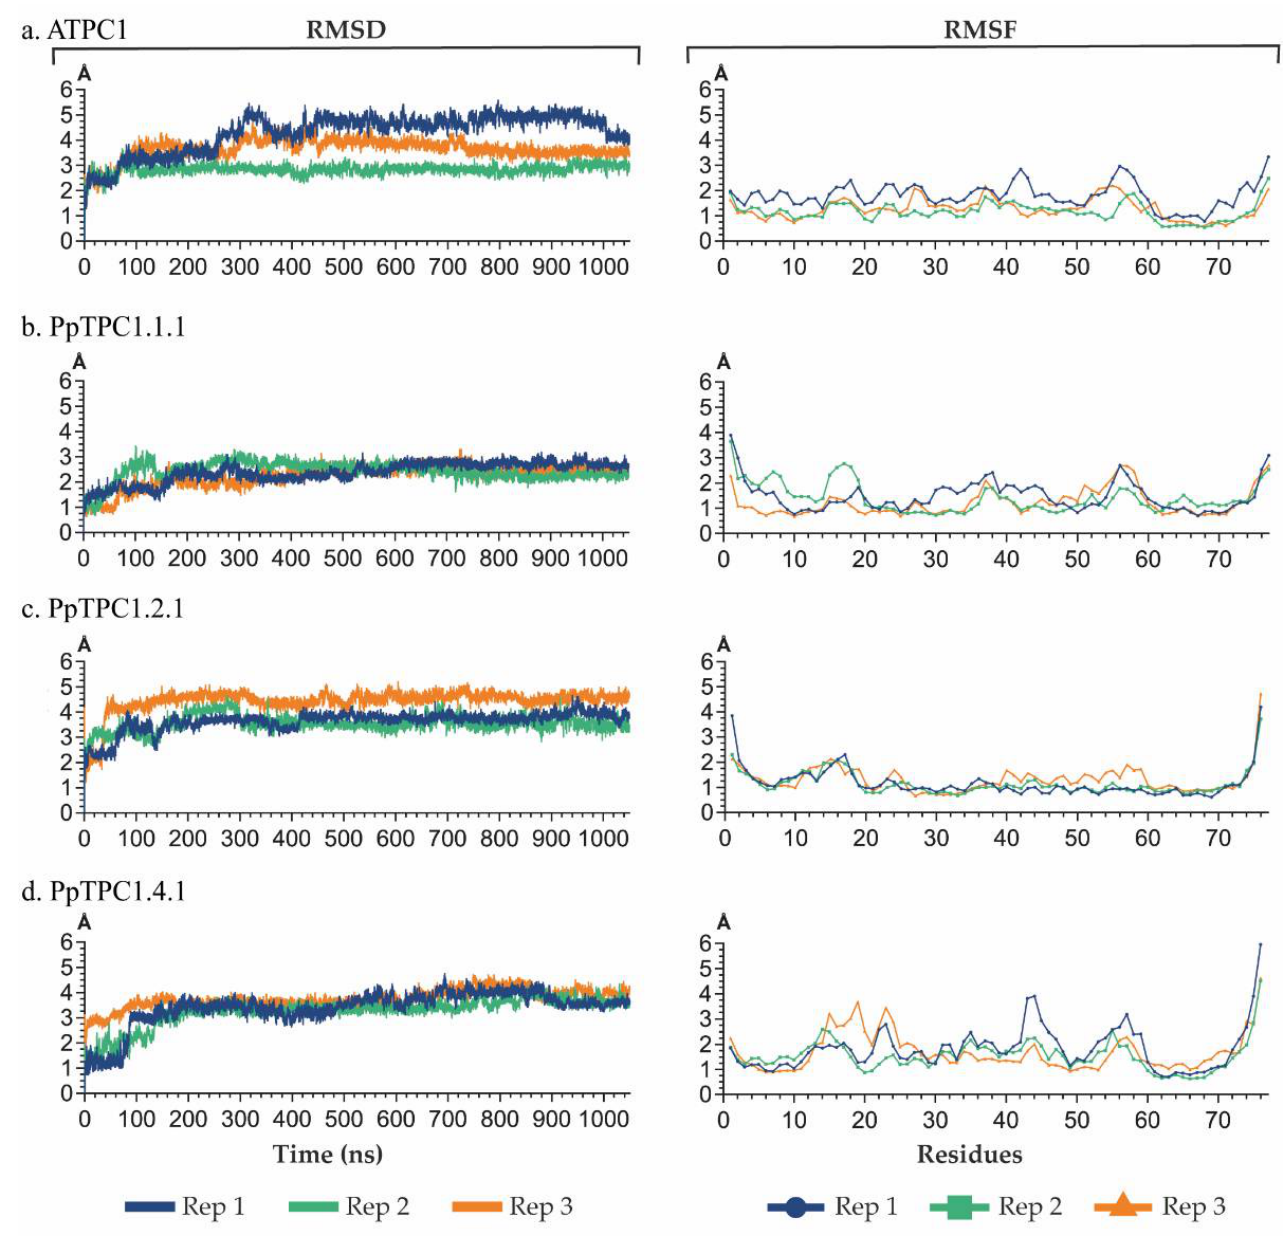
Figure 5. Analysis of the root-mean-square deviation (RMSD) and root-mean-square fluctuation (RMSF) of the MD simulations of the EF-hand domains from ( a ) AtTPC1, ( b ) PpTPC1.1.1, ( c ) TPC1.2.1, and ( d ) TPC1.4.1. In both RMSD and RMSF, the blue, green, and orange curves represented the 1050 ns for each. The RMSD and RMSF analyses were performed using the first molecular dynamics frame as a